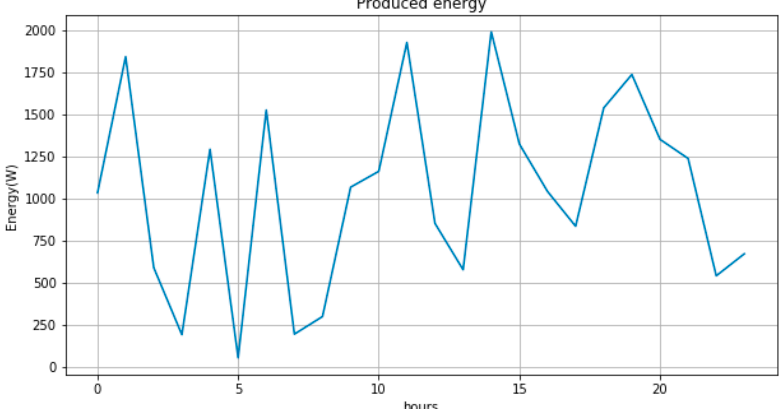
Figure 6. Example of daily distribution of energy produced by a micro-producer generated by the simulator.